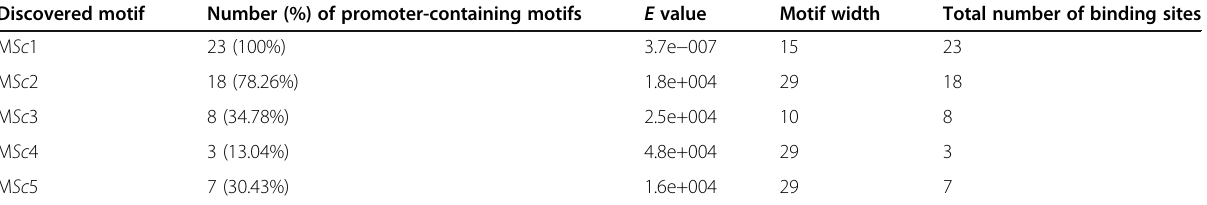
Table 3 List of discovered motifs and the number and proportion of promoter-containing motifs for S. cerevisiaea S288C Discovered motif